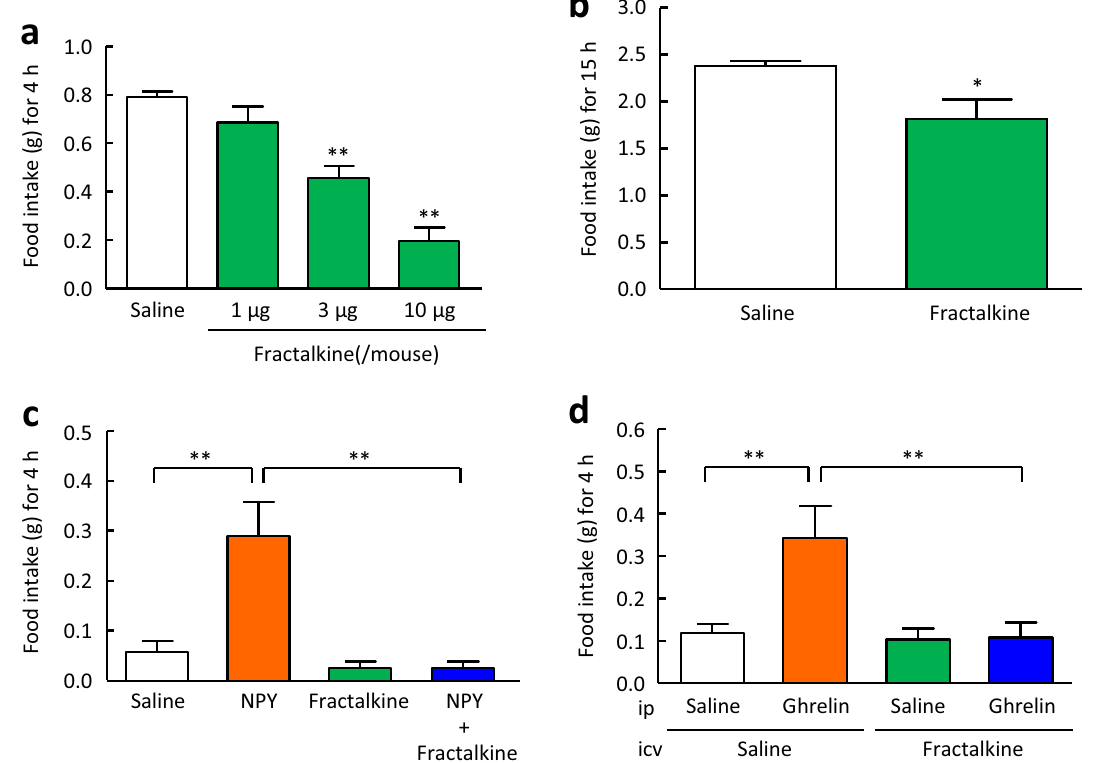
Figure 2. Effects of intracerebroventricular administration of fractalkine on food intake in mice. ( a ) Effects of intracerebroventricular administration of fractalkine (1, 3, and 10 μg/mouse) on food intake during 4-h refeeding after 48-h fasting in mice. ( b ) Effects of intracerebroventricular administration of fractalkine (3 μg/ mouse) on nocturnal food intake in mice. ( c ) Effects of intracerebroventricular administration of fractalkine (3 μg/mouse) on NPY-induced (20 μg/mouse, intracerebroventricular administration) food intake in mice. ( d ) Effects of intracerebroventricular administration of fractalkine (3 μg/mouse) on ghrelin-induced (360 μg/ kg, intraperitoneal administration) food intake in mice. Results are expressed as mean ± SEM for 5–12 mice. Significant differences: * p < 0.05, ** p <